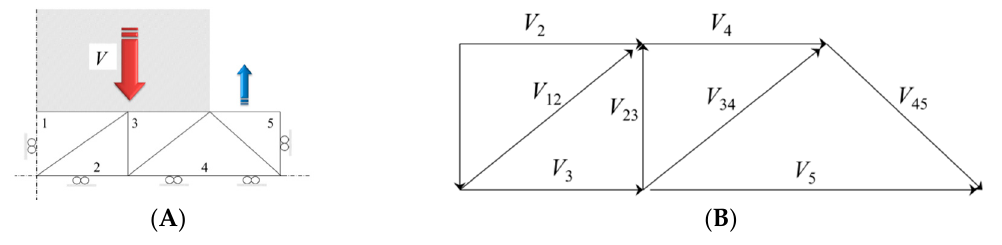
Figure 1. Upper Bound Theorem (UBT) Indentation Analysis. Triangular Rigid Zone (TRZ) distribution ( A ) and Kinematically Admissible Velocity Field (KAVF) analysis ( B ).